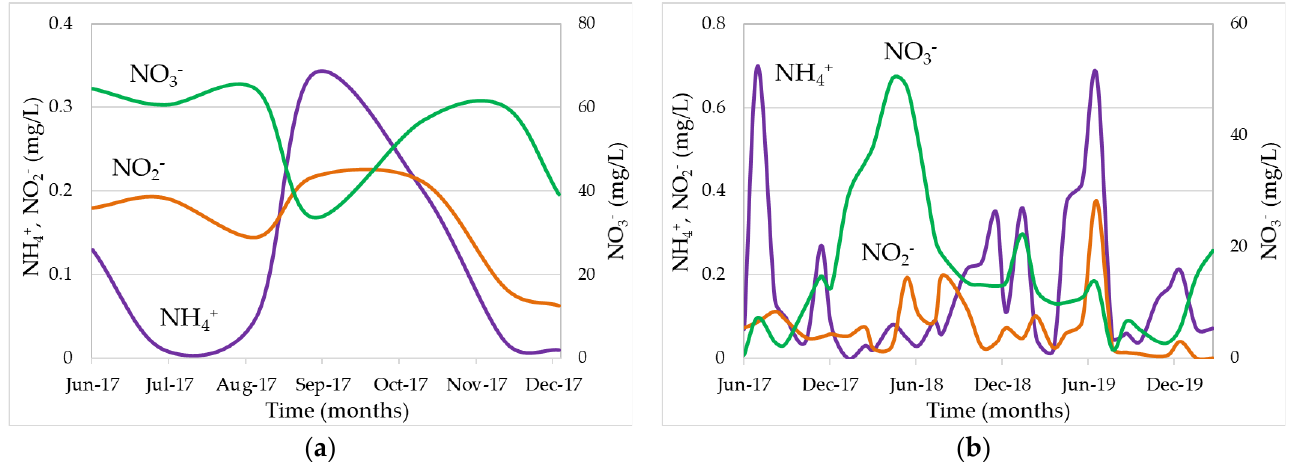
Figure 3. Relationship between the nitrate, ammonia, and nitrite concentrations of the ( a ) active gravel pit and ( b ) inactive gravel pit.